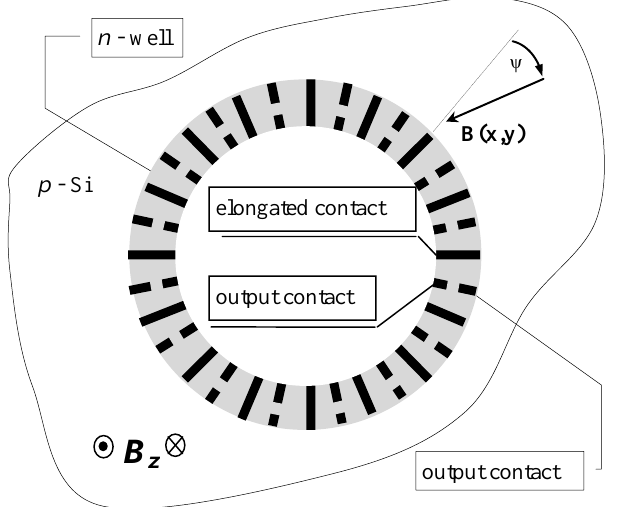
Figure 1. The new circular Hall 3D magnetometer based on a four-contact Hall microsensor using conventional CMOS technology.